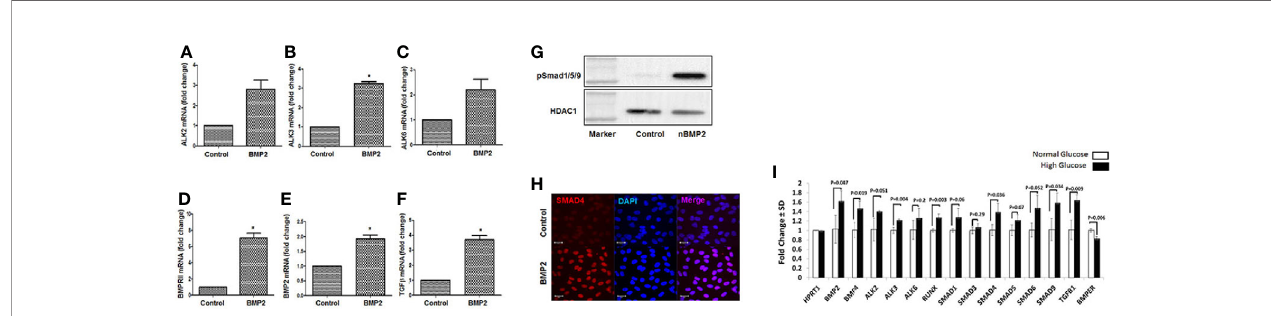
FIGURE 2 | Effect of rhBMP2 or high glucose on BMP receptors and smad system. RT-PCR analysis of the messenger RNA (mRNA) of BMP receptors Alk2 (A) , ALK3 (B) , ALK6 (C) and BMPRII (D) , BMP2 (E) and TGF b (F) in human retinal endothelial cells (HRECs) subjected to rhBMP2 (50ng/ml) for 24 h. There is a signi fi cant increase in the expression of BMP receptors ALK3 and BMPRII. There was also a marked increase ALK2 and ALK6 expression although this increase did not reach to signi fi cant levels. Also, BMP2 treatment induced signi fi cant increase in BMP2 and TGF b mRNA expression. Western blotting of HRECs nuclear extract showing upregulation of nuclear psmad1/5/9 (G) . IF of smad4 showing marked increase in nuclear (blue) immunereactivity of smad 4 (red) by rhBMP2 (H) . n=6 (*P < 0.05). (I) The effect of hyperglycemia on various components of BMP2 signaling pathway. RT-PCR analysis of mRNA expression of various components of BMP2 signaling pathway in HRECs that were subjected to LG-CM or HG-CM treatment for